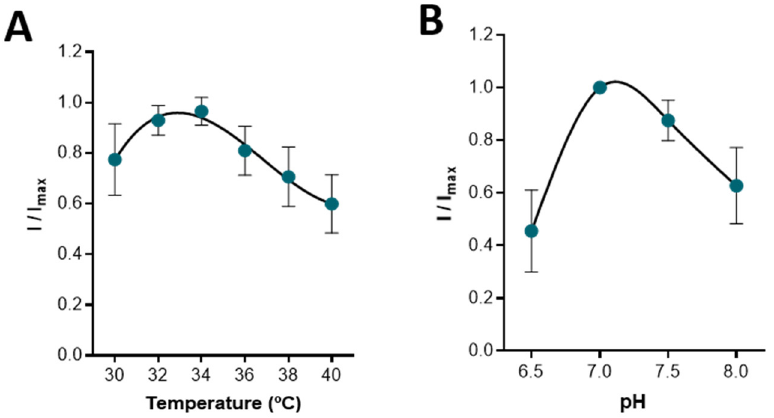
Figure 3. Effect of temperature ( A ) and pH ( B ) on the response of the CFM/Pt-LOx-PU biosensor to 0.5 mM lactate. Data represents mean ± SEM ( n = 3). For each microbiosensor tested, the current for each temperature or pH value was normalized for the maximal response obtained (I/I max ).